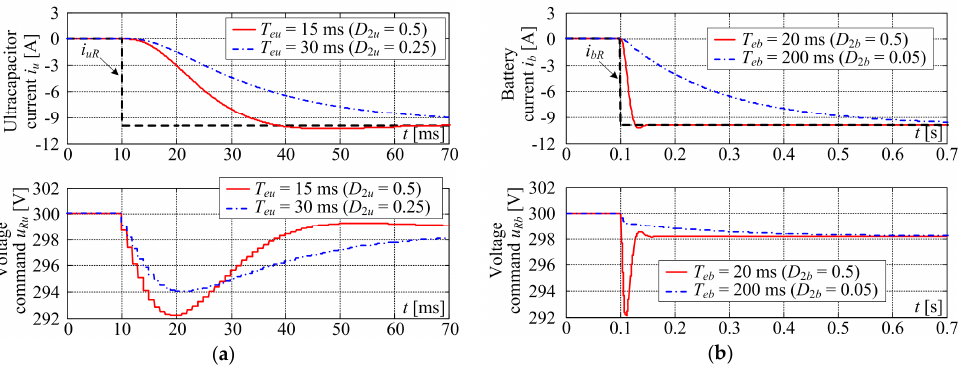
Figure 8. Results of simulation analysis of ultracapacitor ESS ( a ) and battery ESS ( b ) current control systems, illustrating the damping optimum tuning procedure and its ability to arbitrarily adjust closed-loop response speed.